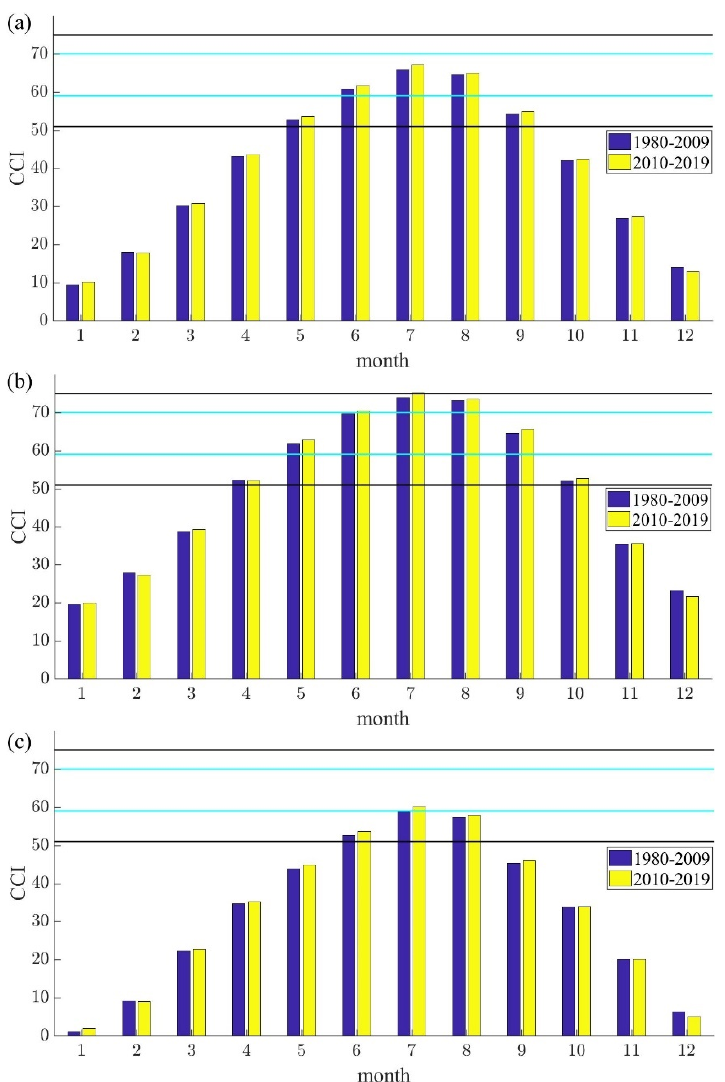
Figure 6. Monthly climate comfort index ( CCI ) of 2010–2019 and 1980–2009 in Jilin Province, China (( a ): CCI of the average temperature, ( b ): CCI of average maximum temperature, ( c ): CCI of average minimum temperature).